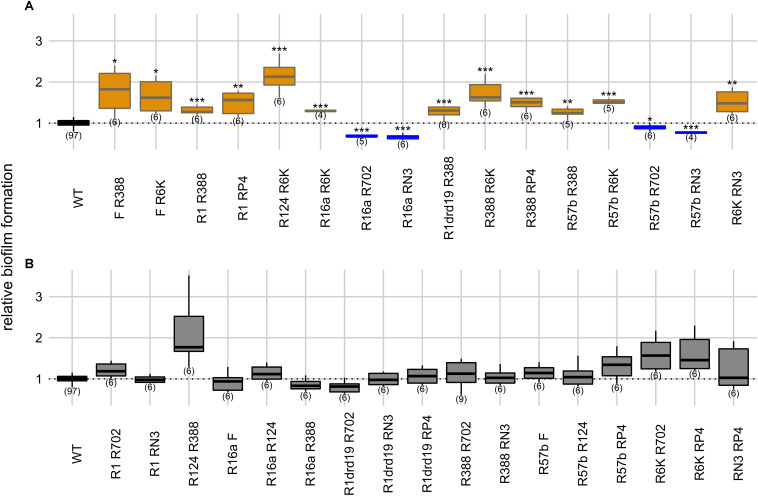
Intercellular effects of two plasmids on biofilm formation. Panels indicate significant (A) and non-significant effects (B) on biofilm formation relatively to the plasmid-free strain. Y axis represents biofilm formation relative to the plasmid-free strain (WT). Plasmid combinations are indicated in the x axis and the number of biological replicates below the boxes (in parenthesis). Results of Dunnett’s multiple comparison test against the plasmid-free strain are indicated as: *p-value < 0.05; **p-value < 0.01; ***p-value < 0.001. Box color, as in Figures 1 and 3, indicates the phenotype qualitatively, such that biofilm formation: increased significantly (orange), decreased significantly (blue), or did not change significantly (light gray in panel B). Dark gray indicates the plasmid-free reference strain.